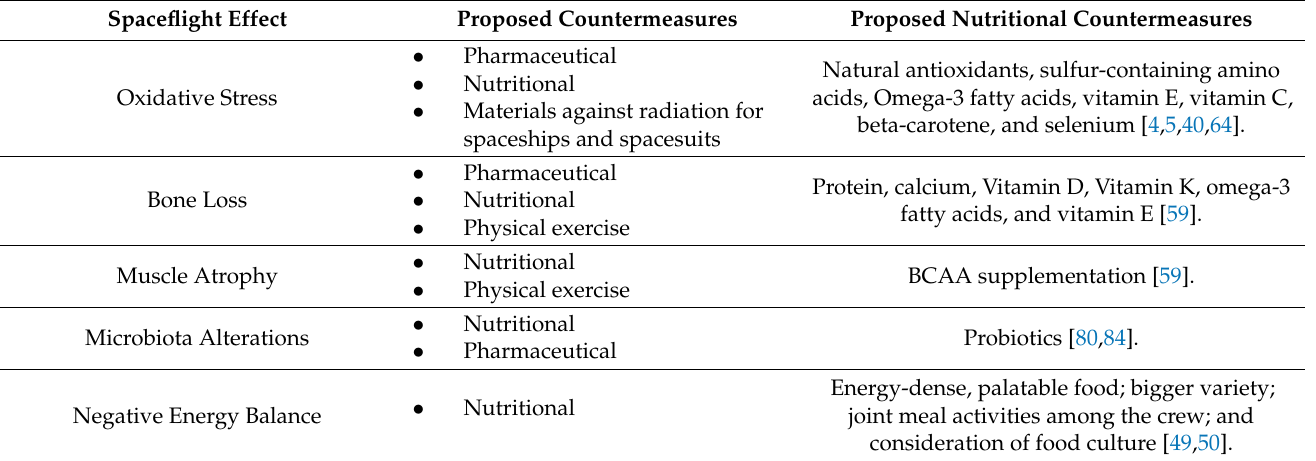
Table 1. Proposed Nutritional Countermeasures Against Spaceflight-Induced Effects on Astro- nauts’